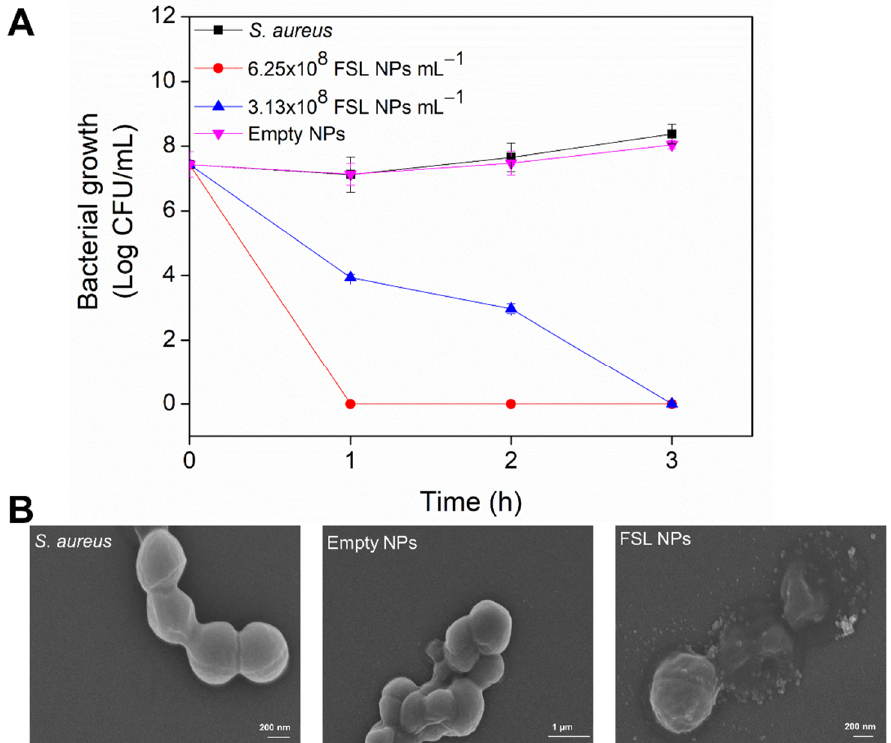
Figure 3. ( A ) Time−killing kinetics of empty and FSL NPs and the bacteria surviving after treatment for 1, 2, and 3 h. ( B ) SEM images of S. aureus without any treatment and incubated with empty or FSL NPs.